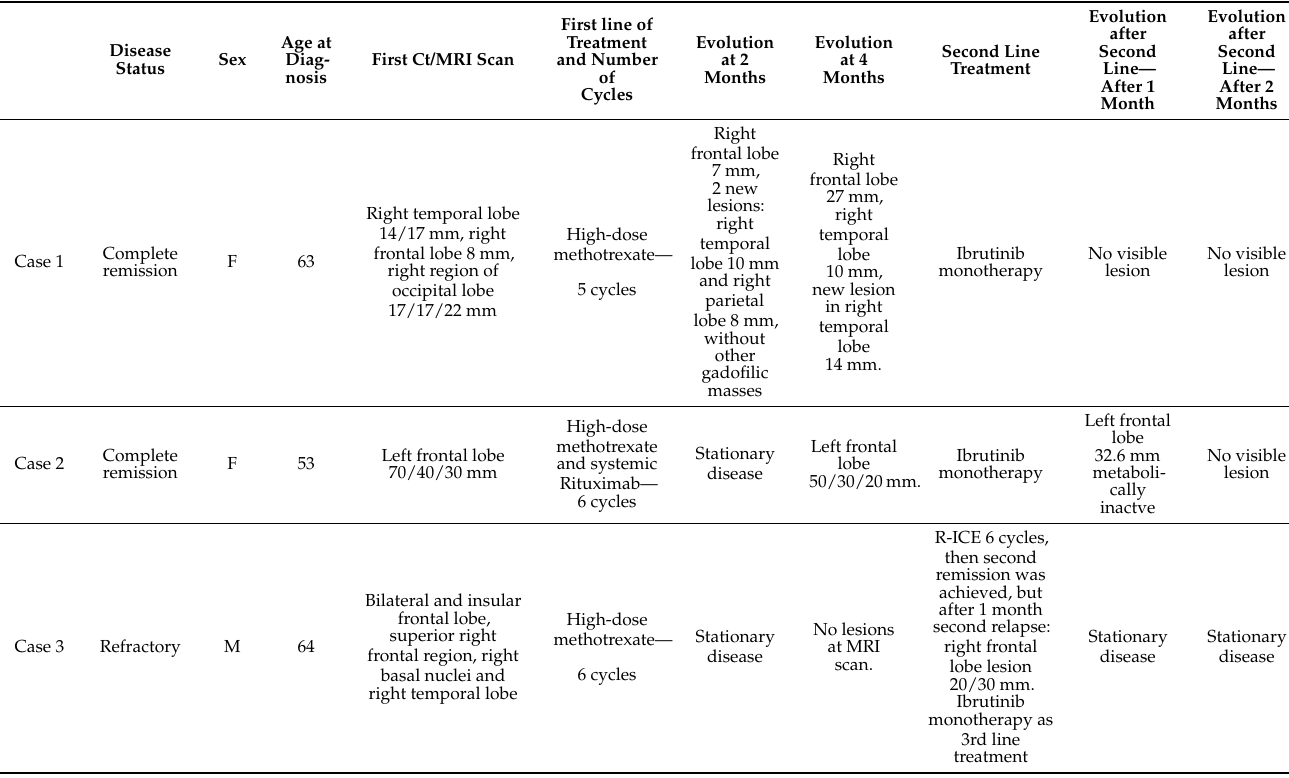
Table 1. Clinical evolution of the